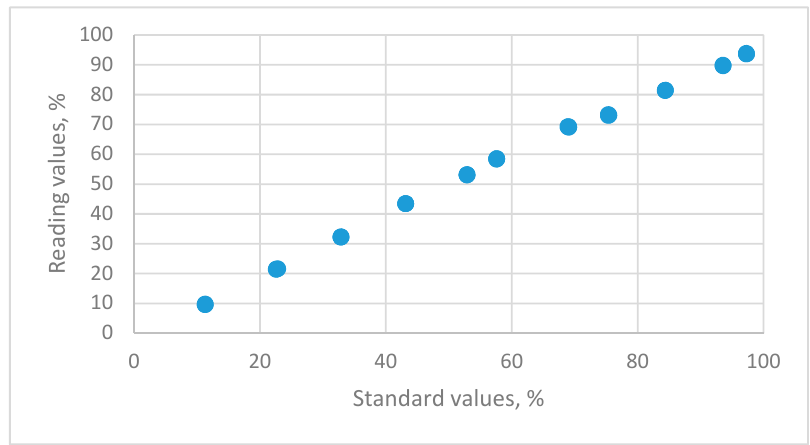
Figure 4. The distributions of relative humidity data for standard humidity values versus the reading values for HMP 140A capacitance humidity sensors using 11 saturated salt solutions (LiCl, CH 3 COOK, MgCl 2 , K 2 CO 3 , Mg(NO 3 ) 2 , NaBr, KI, NaCl, KCl, KNO 3 and K 2 SO 4 ).